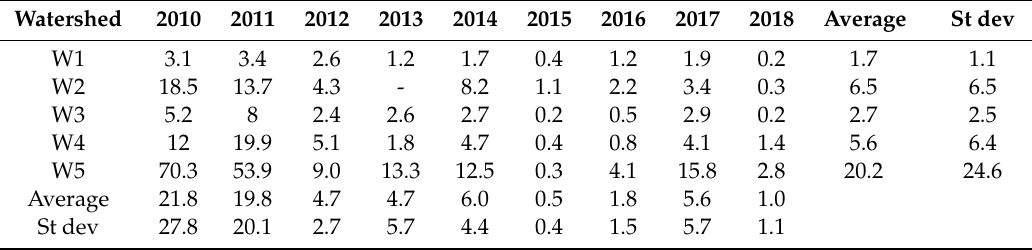
Table 2. Annual and average soil loss (Mg ha − 1 a − 1 ) and standard deviation (st dev) for the Debre Mawi watershed. Soil and water conservation practices (SWCPs) were installed from 2012 to 2014.